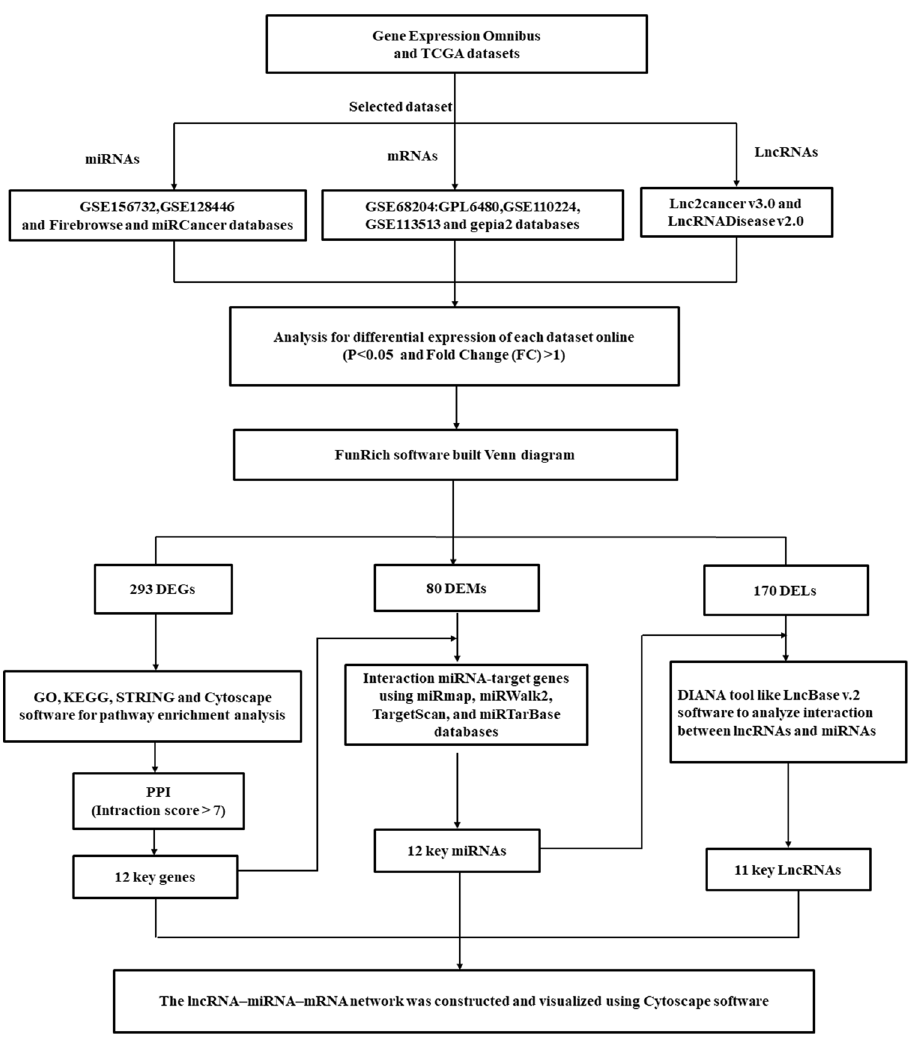
Figure 11. A flowchart diagram for used bioinformatics analysis in the present